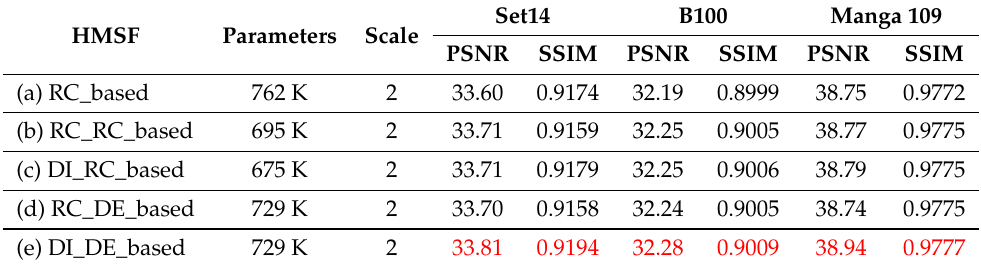
Table 5. The ablation experiment of the use of RC/DI/DE (regular/dilated/deformable convolution). Red text means the best